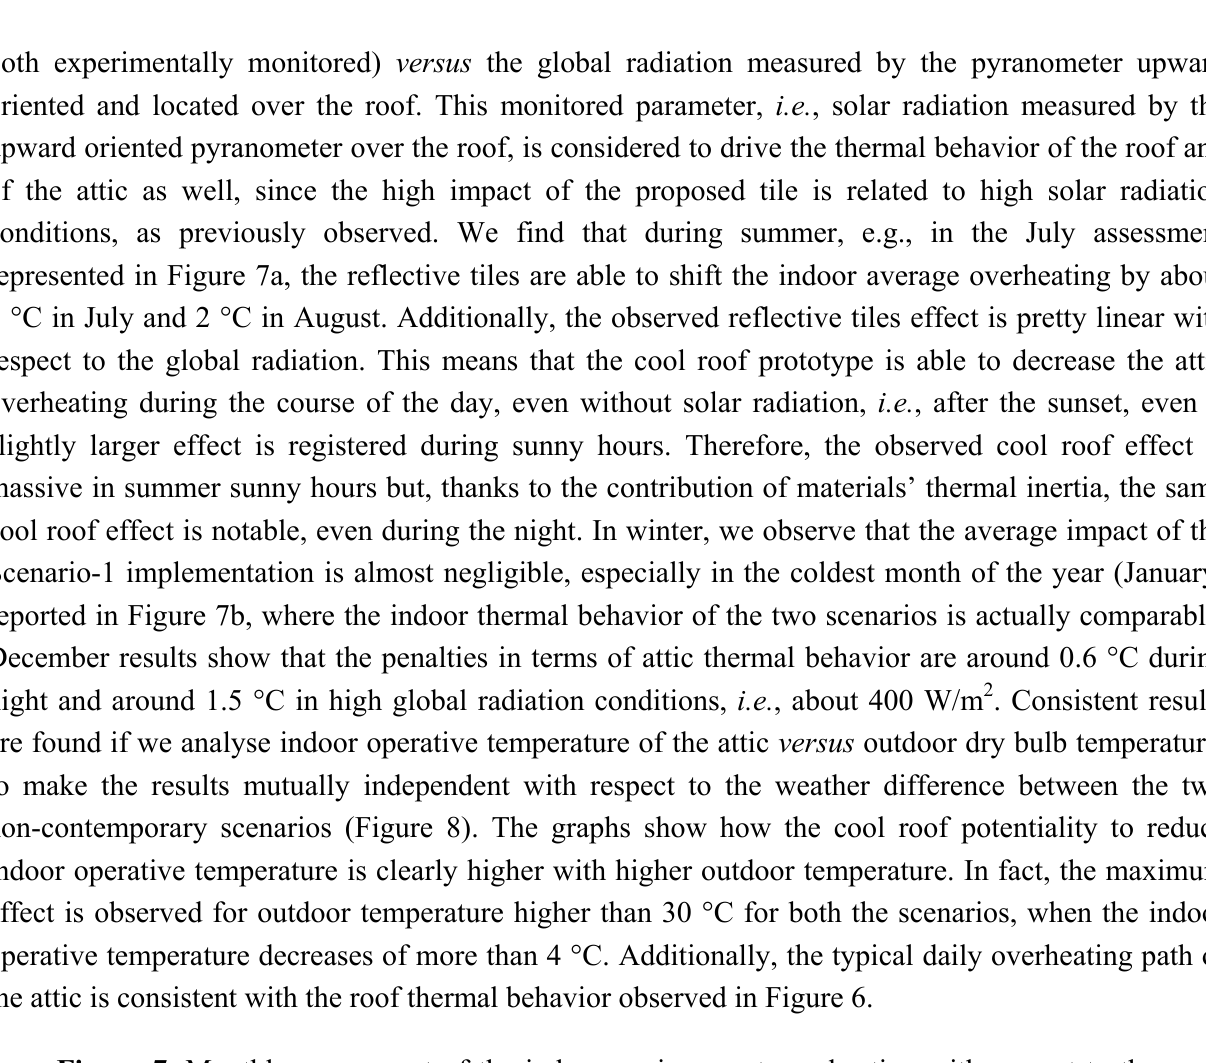
Figure 7. Monthly assessment of the indoor environment overheating with respect to the global radiation of the location in ( a ) July and ( b )